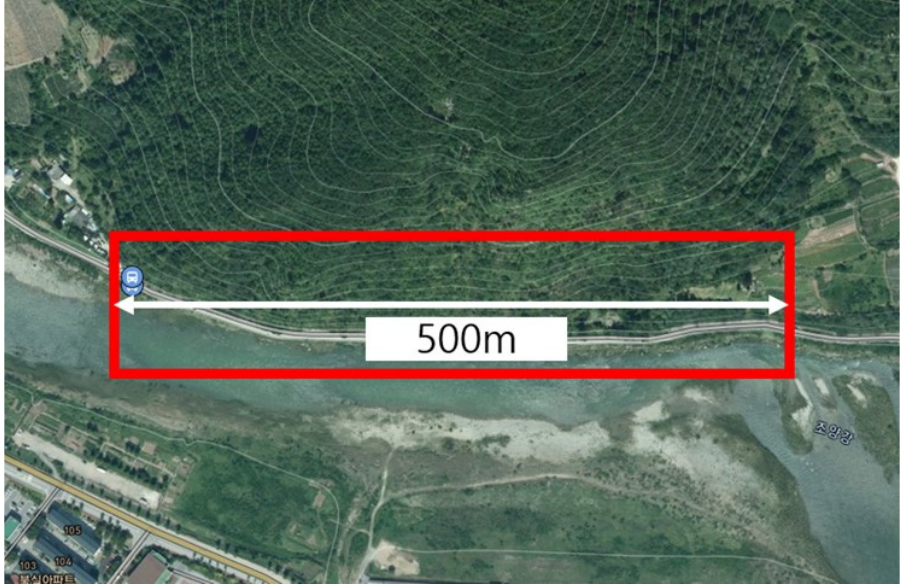
Figure 6. GGSJ area with a length of 500 m .